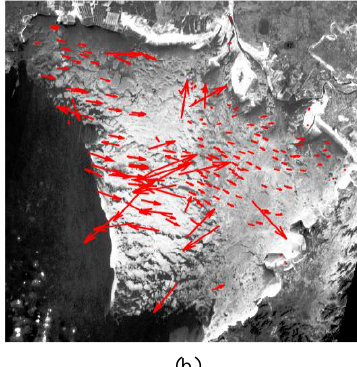
Fig. 7 (a) (b) the sea ice drift monitoring based on improved algorithm for 2017/1/06 and 2018/1/11